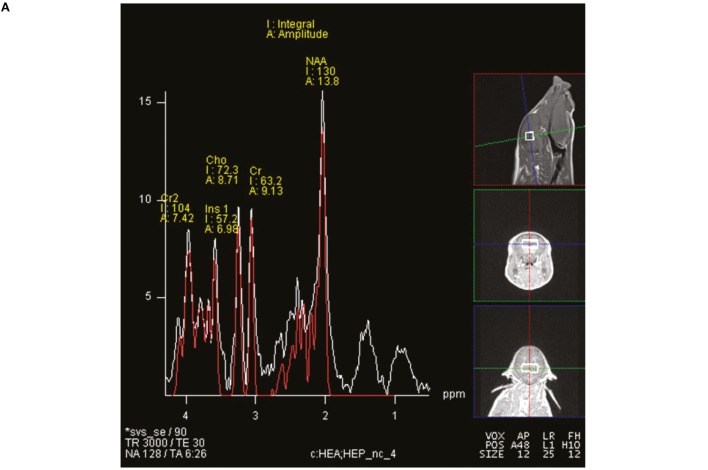
Representative single-voxel spectroscopy spectrum. Single-voxel spectroscopy was used to analyze brain metabolites in piglets. (A) The relative positioning of the voxel, which contains the hippocampi and interstitial space. (B) The acquired spectra with generated data to compare metabolites between AR and SR piglets. A threshold of Cramér–Rao < 20 was used for analyzed metabolites, data are presented as absolute concentrations in parts per million.